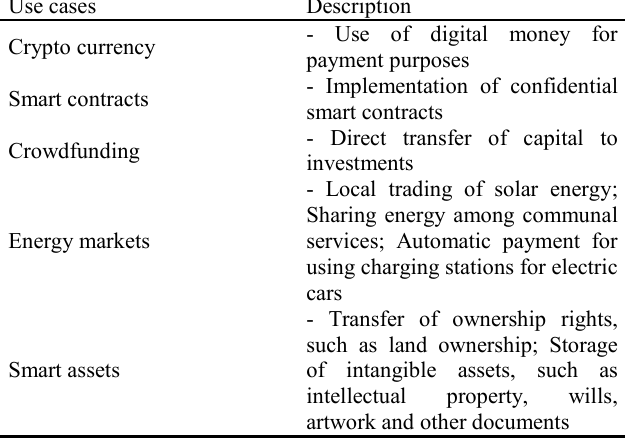
Table 3. Review of blockchain use cases in various